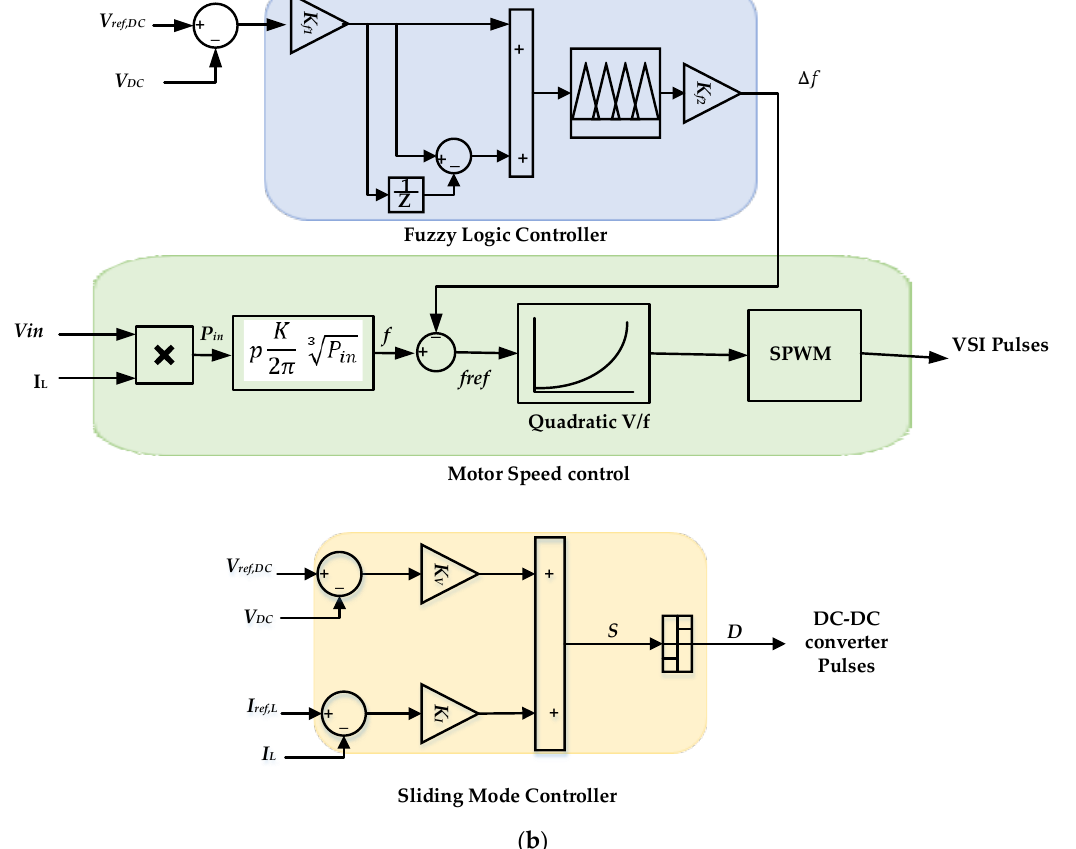
Figure 5. Two proposed control combination with quadratic V/f: ( a ) Q V/f PI-FLC; ( b ) Q V/f SM-FLC.